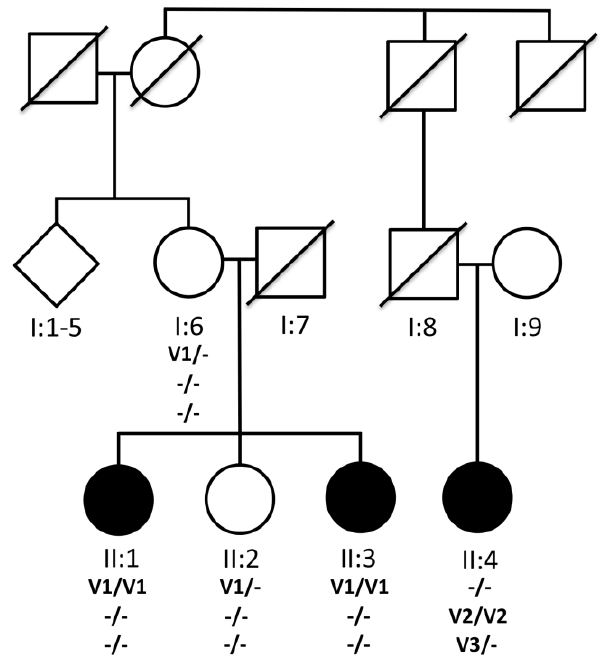
Figure 1. Pedigree RF.L.11.10 and segregation of mutations in KIZ and C21orf2 with recessive RD. I:1–5 represents elder siblings (three unaffected males and two unaffected females) of I:6. (-) Indicates presence of wild type allele whereas V1, V2 and V3 indicate the mutant alleles. The homozygous nonsense mutation p.Arg76* in KIZ (V1) segregated with disease in one branch of the family with